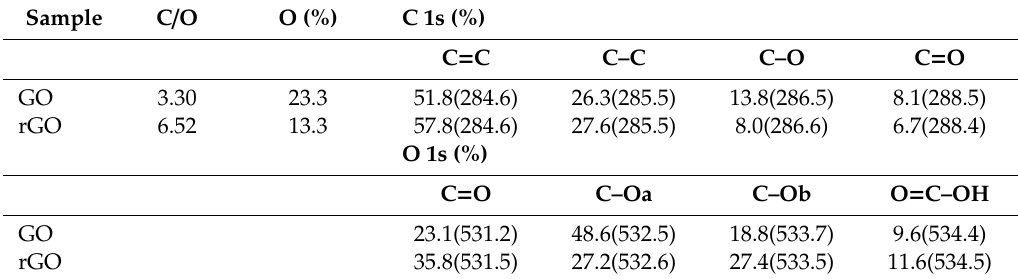
Table 6. C/O ratio, species percentages, bond energies (in brackets, eV), and oxygen content obtained by XPS analysis.